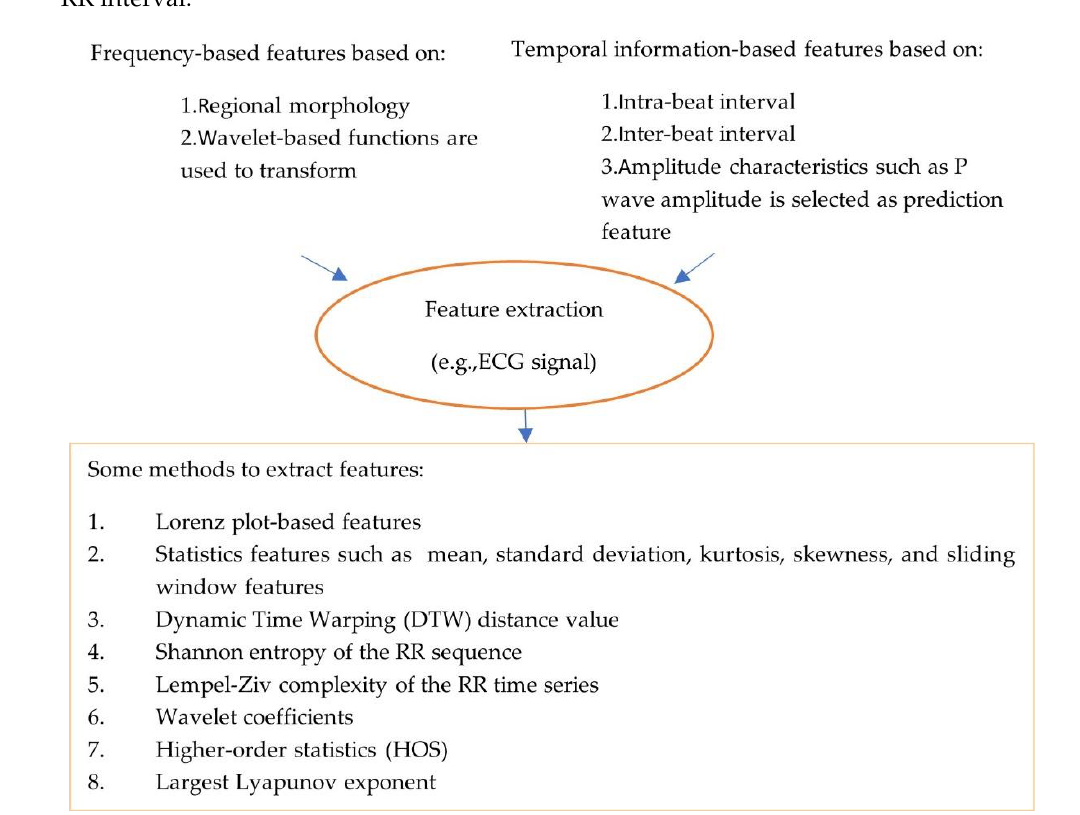
Figure 2. Illustration of types and methods of extracting features.